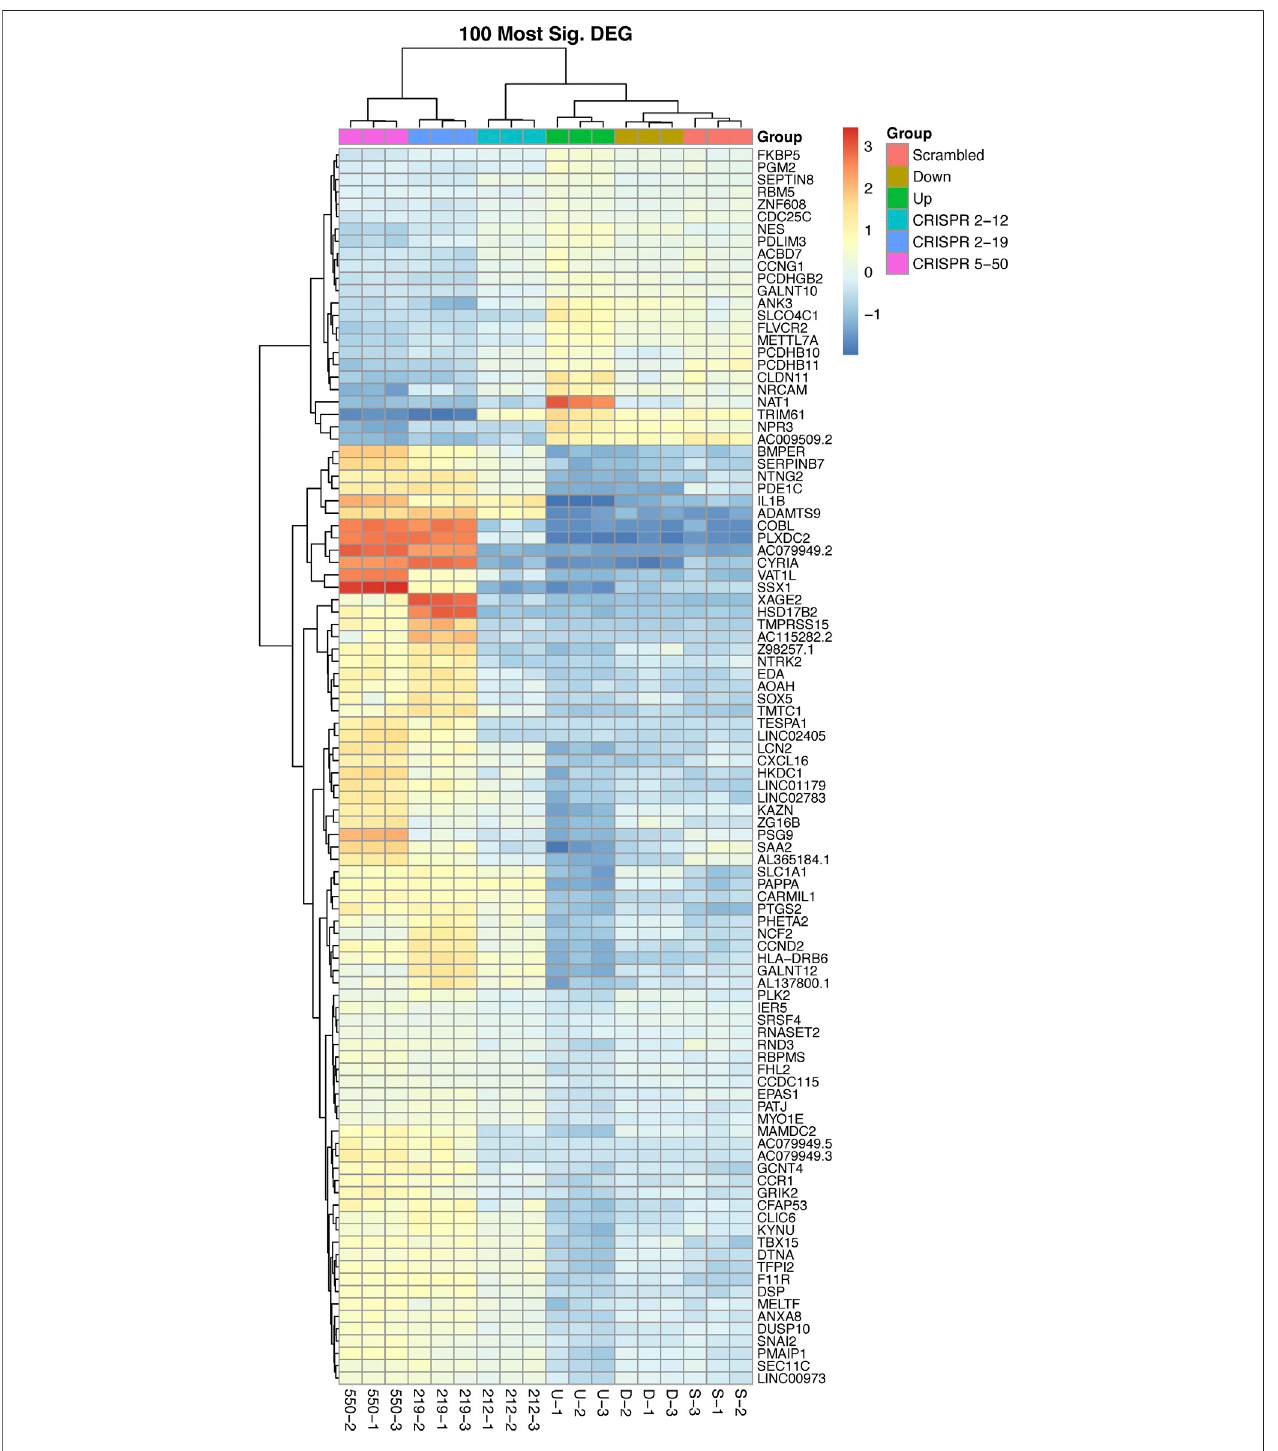
FIGURE 4 | The 100 most differentially expressed genes cluster into two overall groups with distinguishable expression pro fi les. This analysis shows each cell line has a distinct expression pro fi le for the 100 most signi fi cant genes associated with NAT1 activity and that there many genes with similar expression pro fi les across the samples. There are two overall groups that form in terms of similar patterns of expression, those that are positively associated with NAT1 activity (24 — top cluster) and those that are negatively associated with NAT1 activity (76 — bottom cluster). Each row of the heatmap shows the expression for a single gene while each column shows gene expression for an individual sample. Expression values have been transformed to Z-scores with red colors representing high expression and blue colors representing low expression.